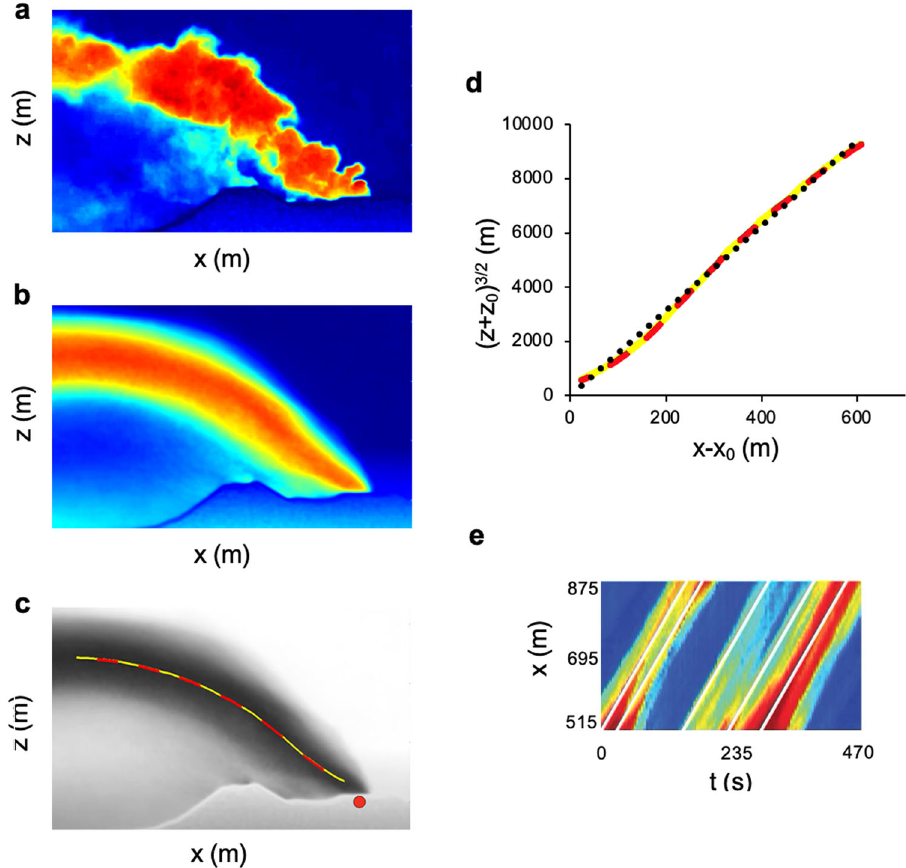
Fig. 7 Volcanic wind-blown plume at Mount Etna (2015). a False colour image of the plume obtained from the UV movie. b Image of the overall shape of the plume in false colour. c The red and yellow dashed lines illustrate the vertical height of the centre of mass in the plume, as estimated directly from the data (red) and also from fi tting the pixel value histogram to a Gaussian distribution at each point along the plume, and mapping the locus of the centre of these Gaussian distributions (yellow). The red dot illustrates the approximate position of the virtual source of the plume. d Comparison of the estimates of height of the centre of mass of the plume as a function of distance downwind (red and yellow dashed curves) with the model curve (Eq. (10)) shown with black dots. e Image of the vertical average of the pixel values at each downwind point in the plume, as a function of time. The white lines indicate the turbulent structures in the fl ow. We used these straight lines to estimate the average wind speed w = 2.3 ± 0.10 ms − 1 , corresponding to an error of about